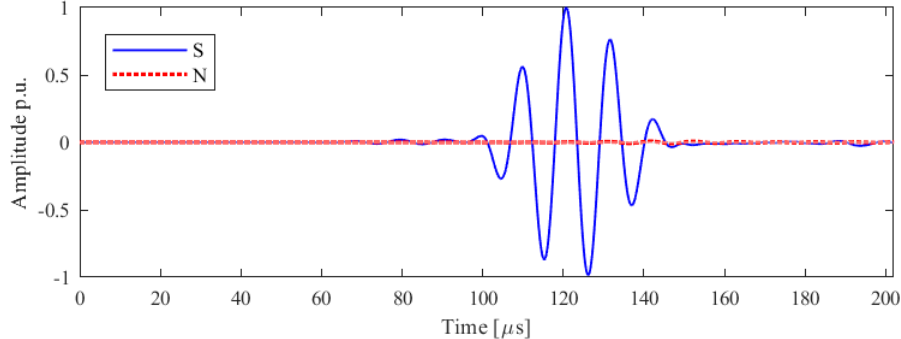
Figure 10. Point source numerical results of the in-plane (blue), ‘S’, and out-of-plane, ‘N’, (red) velocities along the line orthogonal to the line of vibration. Normalized data are shown.